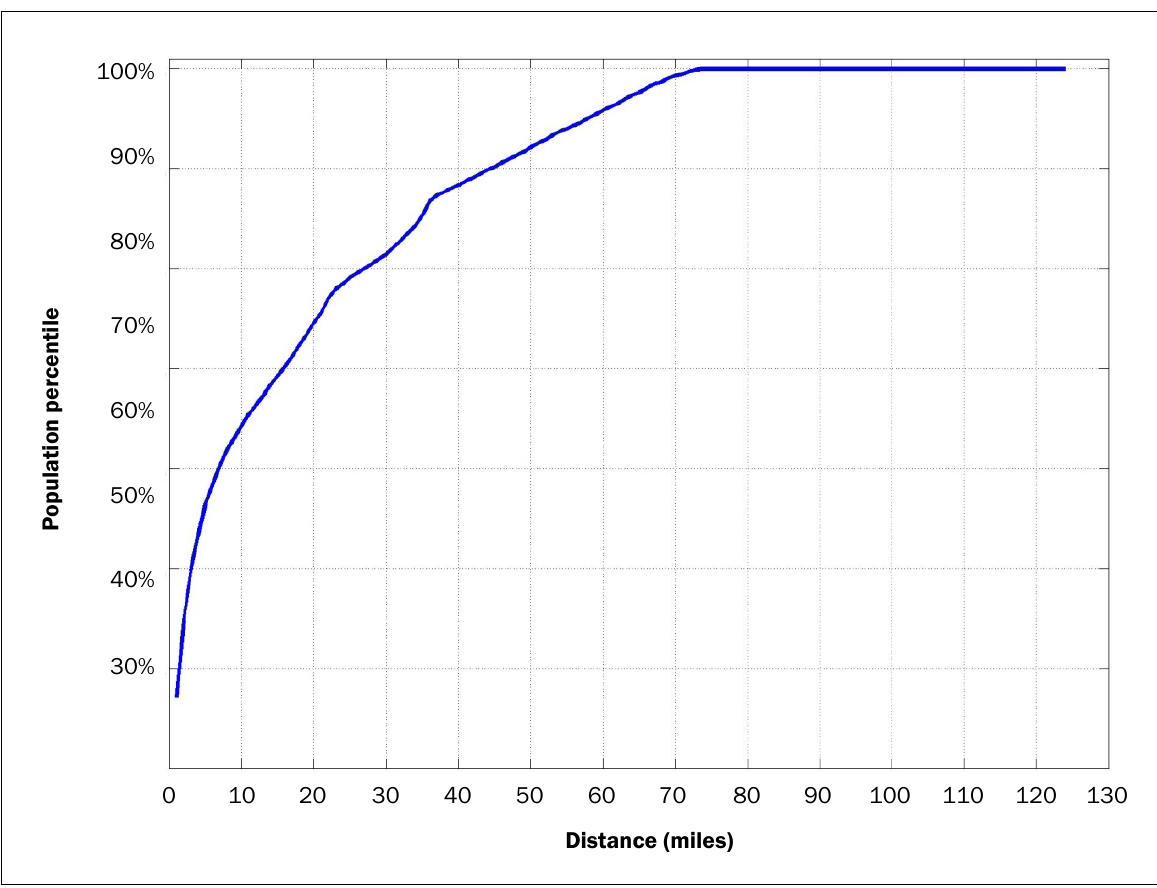
Figure 2. Distribution of Foodshed Distances Within the Study